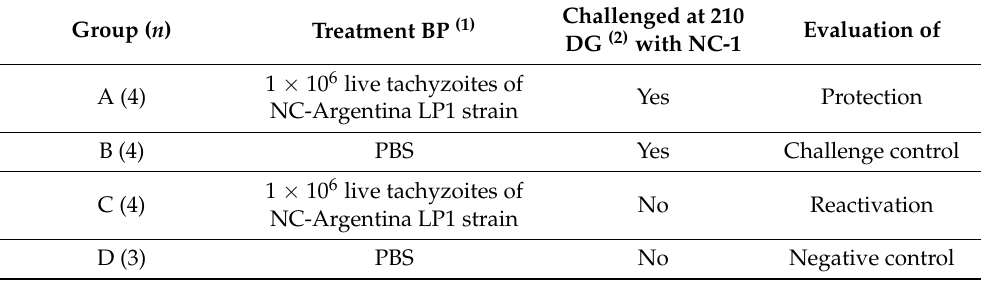
Figure 1. Chronological layout of the experiment. A chronological summary of Experiments 1 and 2 is depicted. Experiment 1 involved the inoculation of prepubertal female calves with the Neospora NC-Argentina LP1 isolate (already described in [11]), while Experiment 2 involved the results included in the present study. Table 1. Study design and groups. (1) BP: before reaching puberty; (2) DG: days of